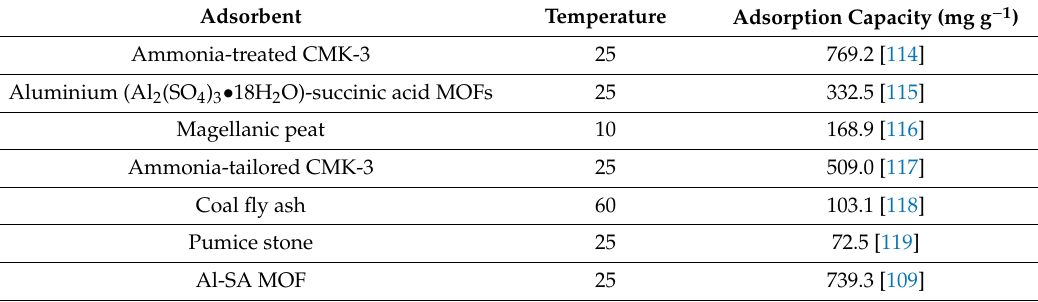
Table 3. Adsorption capacities of various